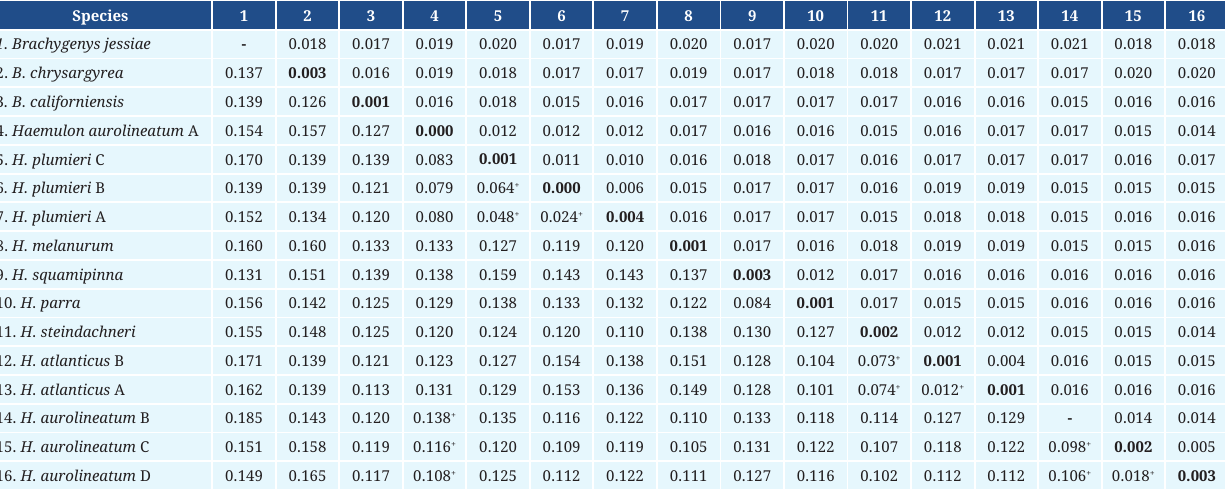
TABLE 2 | Pairwise K2P distances between Brachygenys and Haemulo n genetic lineages (below the diagonal) and standard errors (above the diagonal). The numbers in bold type represent the intraspecific K2P genetic distances. + Only one sample available. The species identified by letters correspond to the distribution of the specimens as described in the